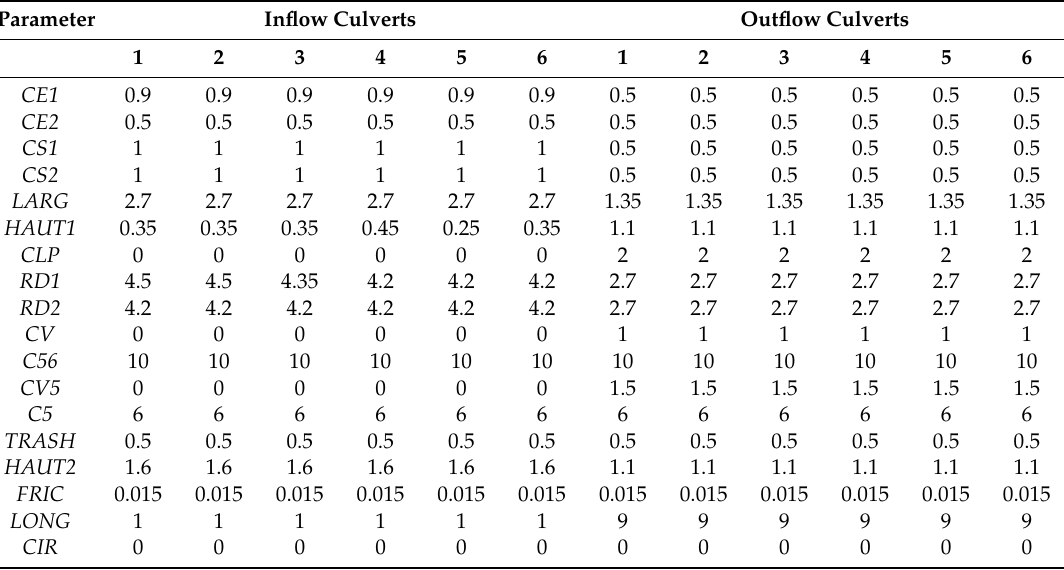
Table A1. FCA with CRT Bergenmeersen culvert parameter values for use in buse.f. Parameter